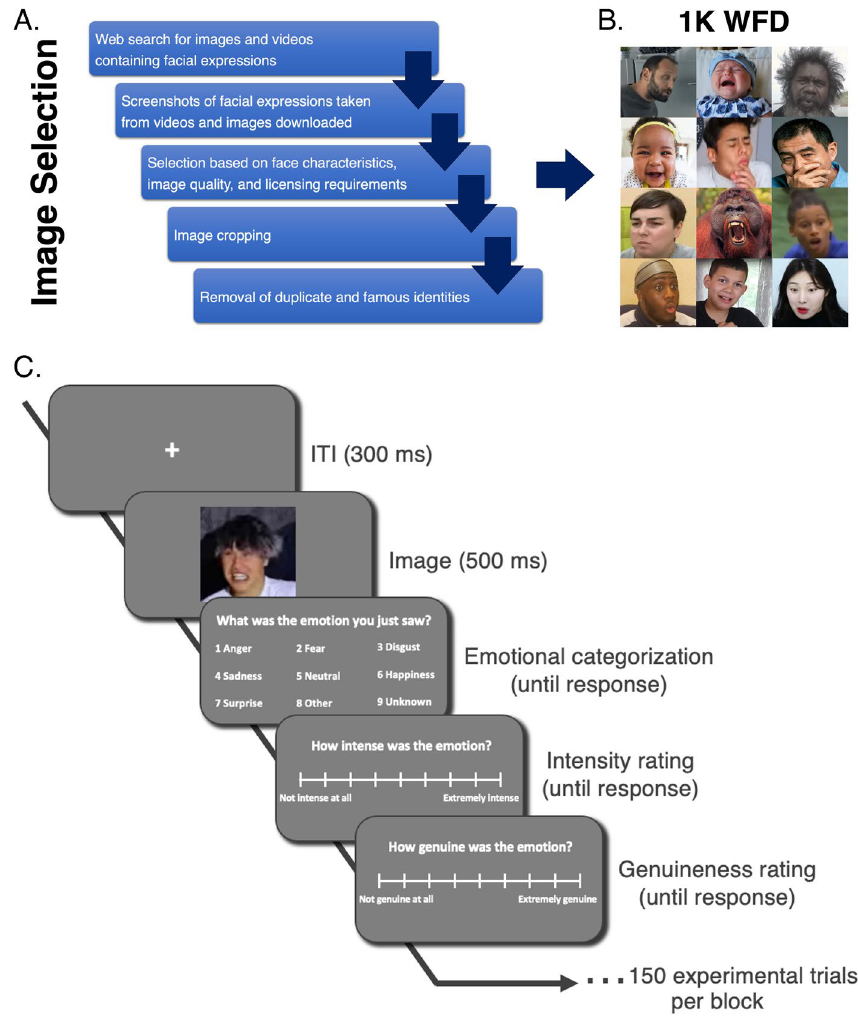
Figure 1. ( A ) Schematic showing the procedure used to identify and select the WFD faces. ( B ) Illustrative examples of the diverse images included in the WFD. ( C ) The trial procedure for the behavioral ratings experiment. On each trial, participants were shown an image for 500 ms followed by a prompt to categorize the emotion displayed in the image using one of nine options. This was followed by prompts to obtain intensity and